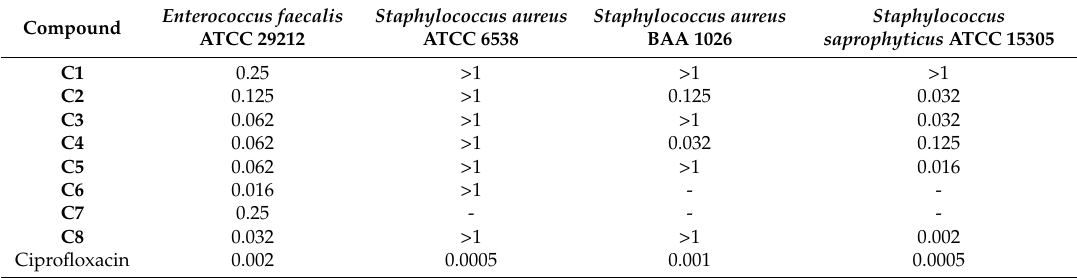
Table 2. The minimum inhibitory concentrations MIC (mg mL − 1 ) values of the tested compounds against the tested microbial strains.